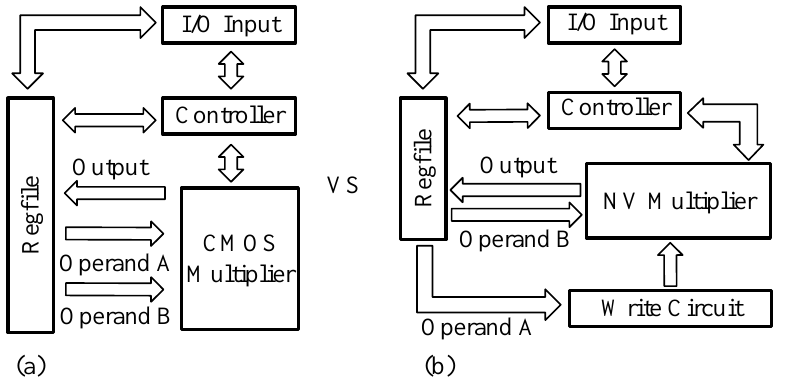
Figure 3. Computing system structure using different multipliers. ( a ) CMOS-based Multiplier [44,45]. ( b ) NVM-Based Multiplier